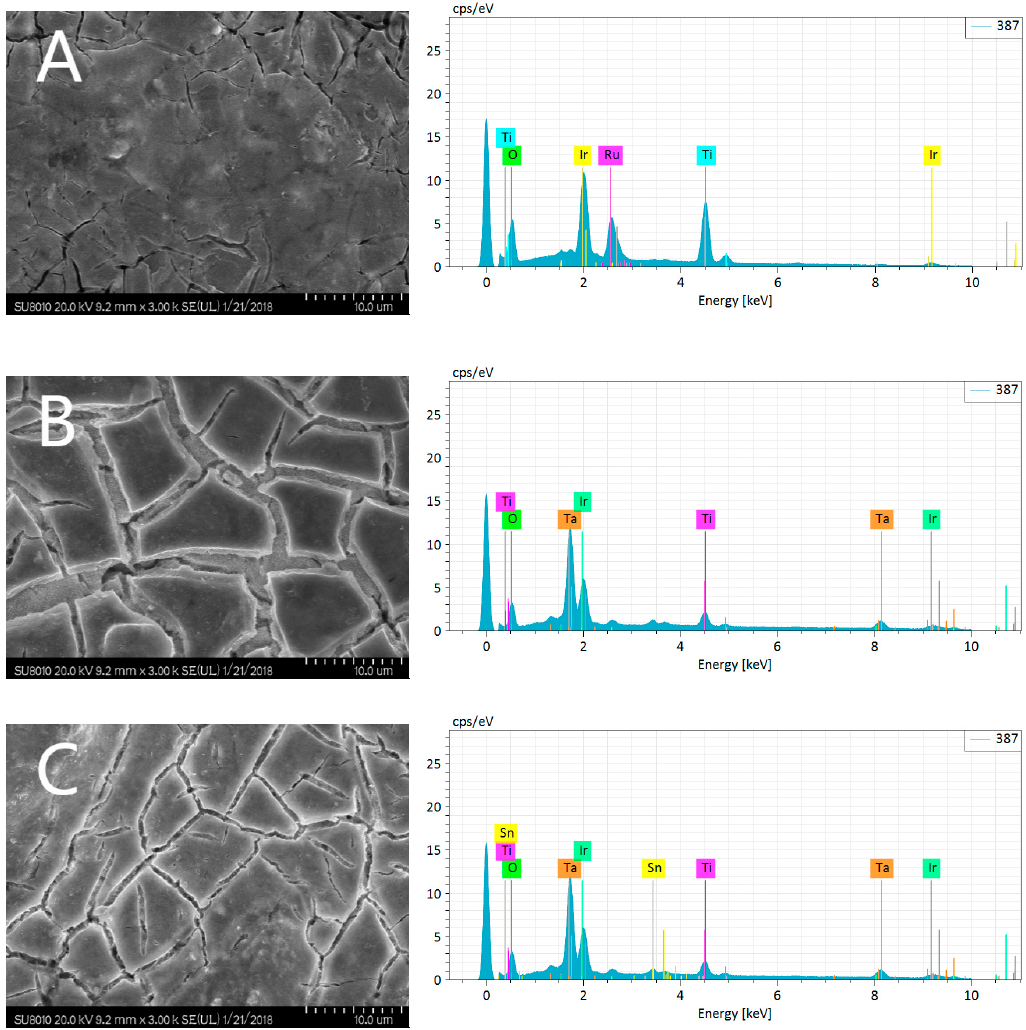
Figure 2. SEM images and energy dispersive spectrometer (EDS) spectra of Ti/RuO 2 -IrO 2 ( A ), Ti/Ta 2 O 5 -IrO 2 , ( B ) and Ti/Ta 2 O 5 -SnO 2 -IrO 2 ( C ).